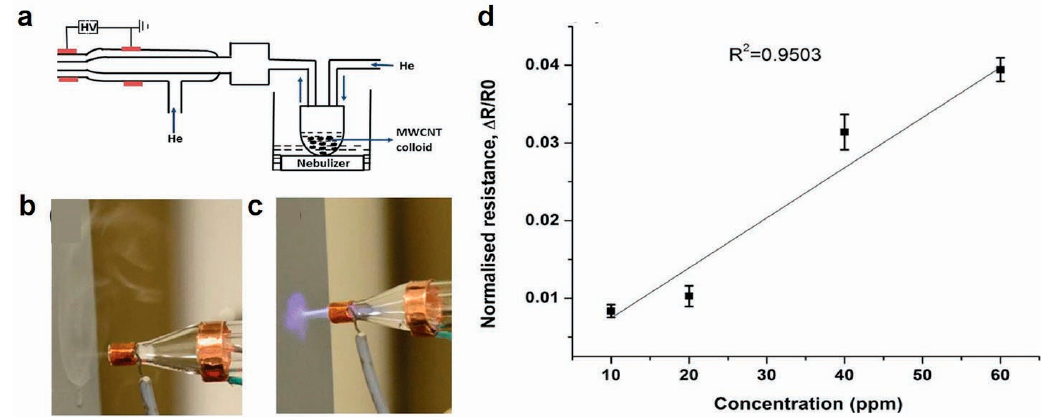
Figure 9. ( a ) Schematic of the atmospheric plasma jet. Photographs of aerosol flow with ( b ) no plasma and ( c ) plasma on. ( d ) MWCNTs on paper as a gas sensor exposed to ammonia in the range of 10–60 ppm. Reproduced with permission from AIP Publishing [106].